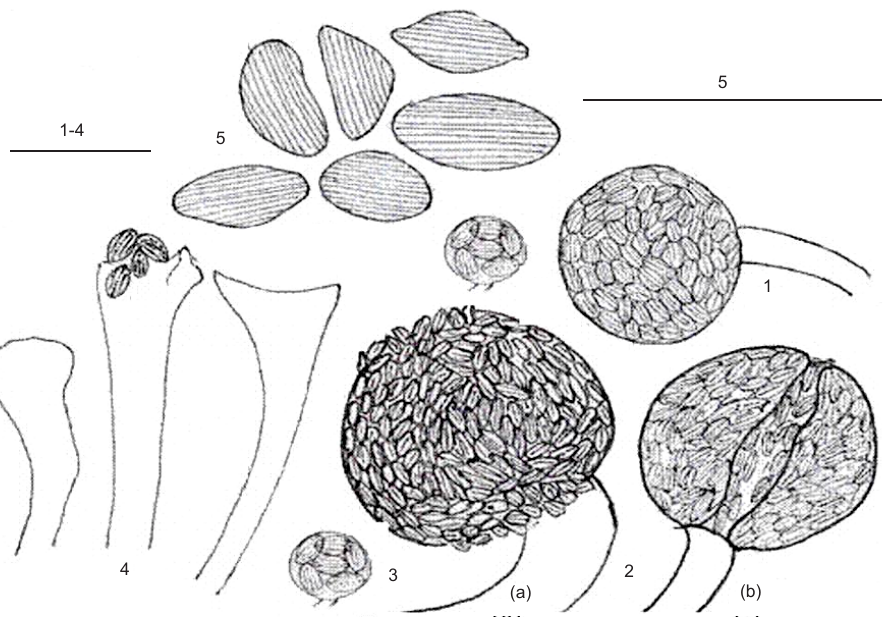
Figure 1-5. Abradeosporangium variosporum gen. et sp. nov. 1 – Macrosporangium (10 x 40X); 2 – Mature sporangia showing (a) dissolution of sporangial wall; (b) breaking of sporangial wall along the longitudinal suture (10 x 40X); 3 – Microsporangia (10 x 40X); 4 – Distal parts of sporangiophores after the dispersal of spores (10 x 40X), note the absence of columella; 5 – Sporangiospores (10 x